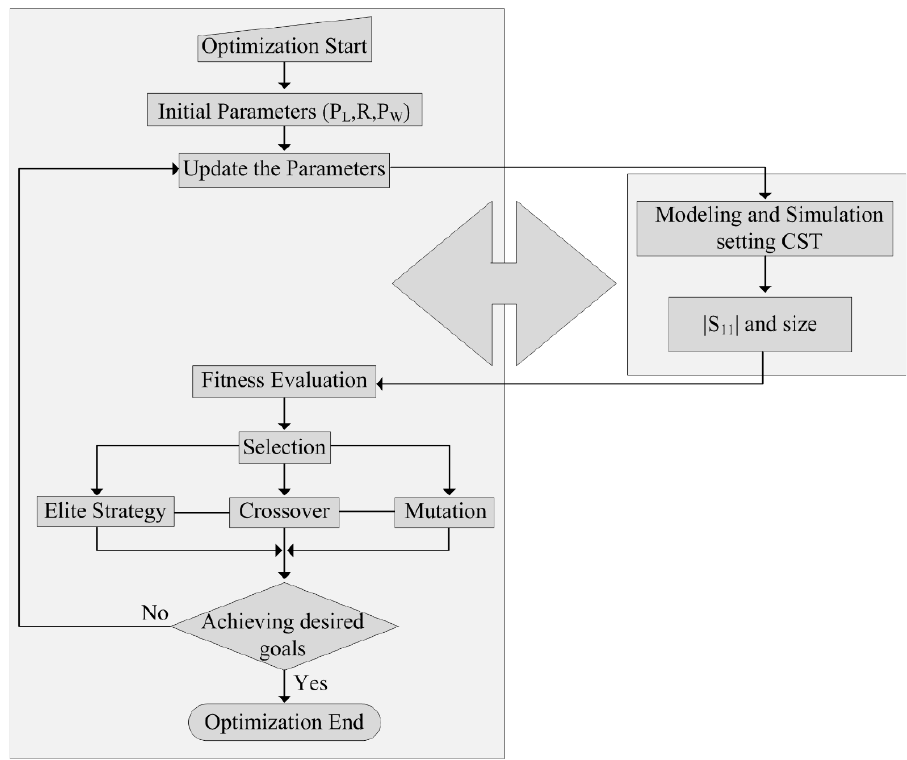
Figure 7. Flow chart illustrating the working principles of the optimization algorithm.